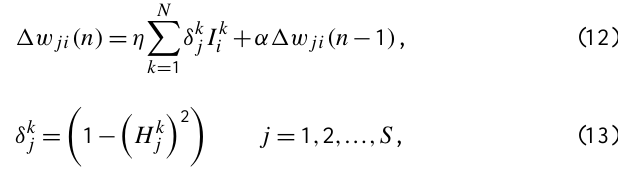
Fig. 2. Architecture of two-layer back-propagation neural network Fig. 4. Architecture of Elman neural Fig. 4. Architecture of Elman neural network